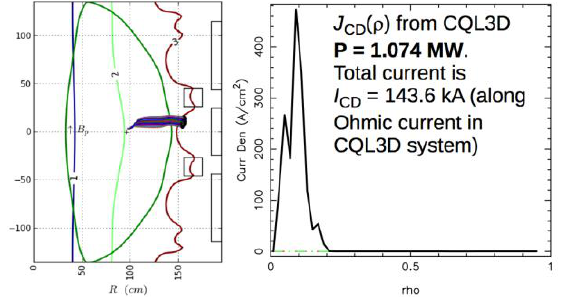
Fig. 15 : Left: O-mode and EBW rays at 37 GHz. Right: the current density as calculated by CQL3D. The efficiency is 0.14 A/W and the corresponding  is 0.63